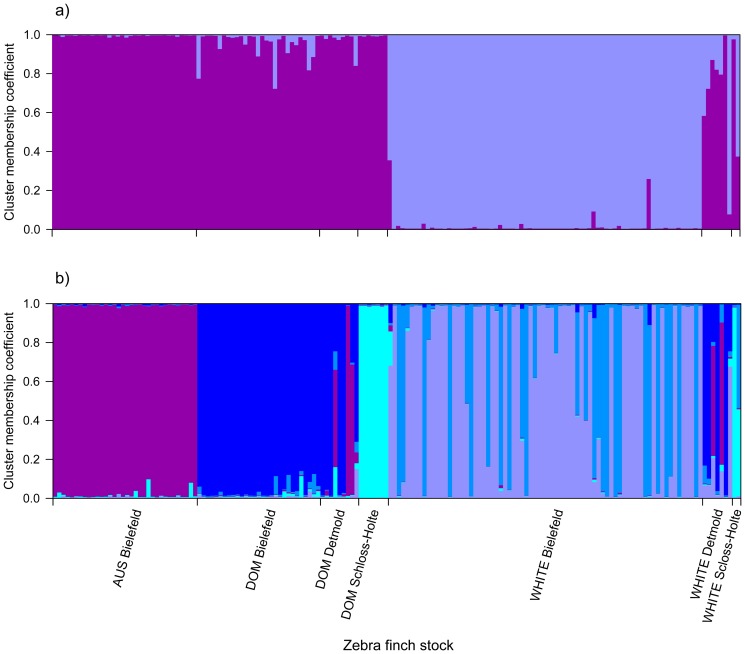
Group membership coefficients derived using the program Structure for 162 zebra finch individuals sorted by stock for (a) K = 2 and (b) K = 5.The first four stocks correspond to the wild type plumage morph and the second three stocks correspond to the white plumage morph. Each individual is represented by a vertical line partitioned into coloured segments, the lengths of which indicate the posterior probability of membership in each group.